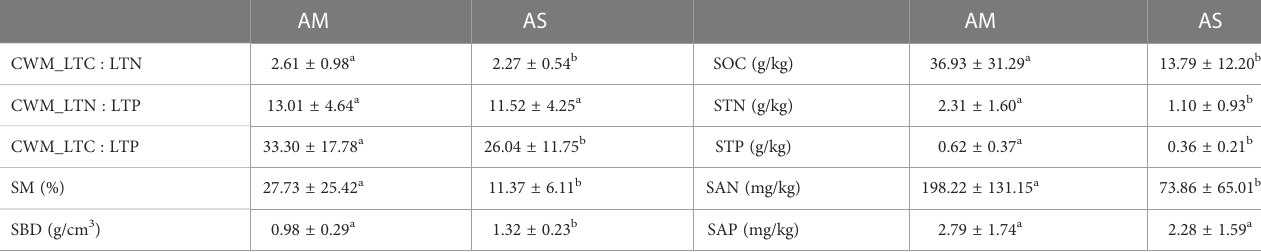
TABLE 1 Differences of plant stoichiometry traits and soil properties in the two different alpine grassland types. AM AS AM AS